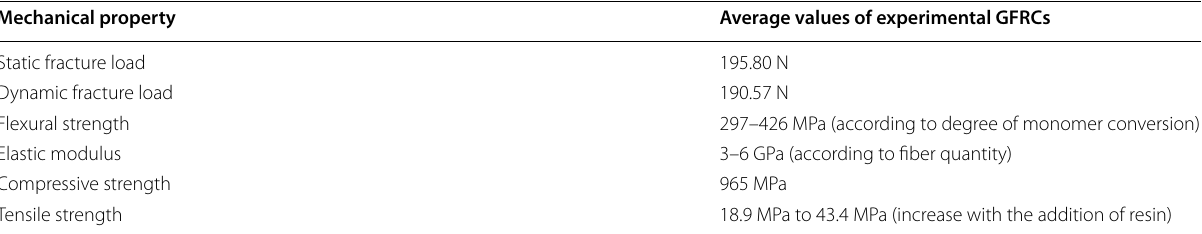
Mechanical property